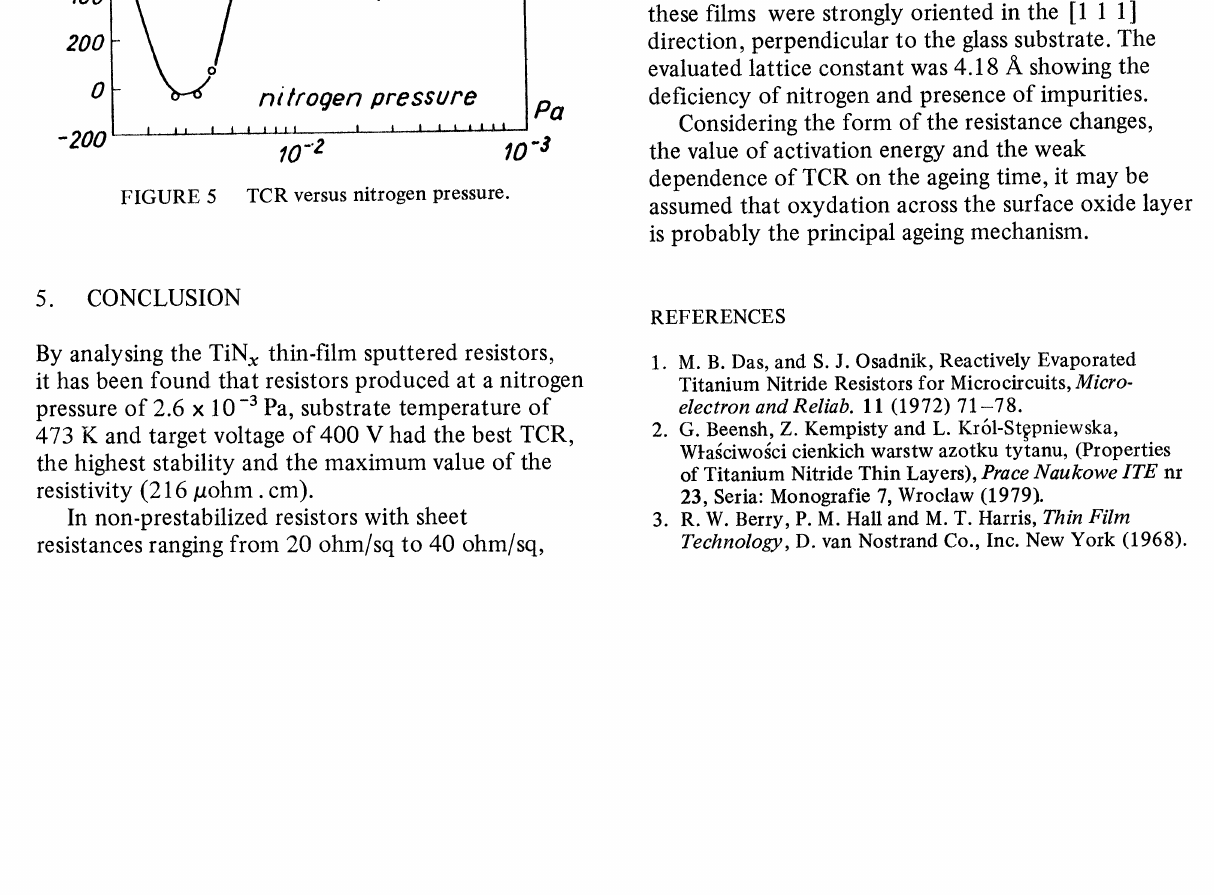
subject to 1000 h oven-ageing at 423 K, the mean value of AR/R was 3.5%, and the mean value of TCR was -35 ppm/K. Standard temperature treatment at 523 K for 5 h causes the mean value of AR/R to be reduced to 0.2% and that of the TCR to -22 ppm/K. It should be emphasized that for reactively evaporated TiNx resistors tested under the same conditions, the value of AR/R and TCR, obtained by the authors of this paper, were 0.35% and-72 ppm/K, respectively. The X-ray diffraction patterns of TiN x film (thickness 2000 A) deposited at nitrogen pressure 2.6 x 10-3 Pa and deposition rate 1.6 )k/s have shown titanium nitride structure of NaC1 type. Thus, these films were strongly oriented in the [1 direction, perpendicular to the glass substrate. The evaluated lattice constant was 4.18 )k showing the deficiency of nitrogen and presence of impurities. the value of activation energy and the